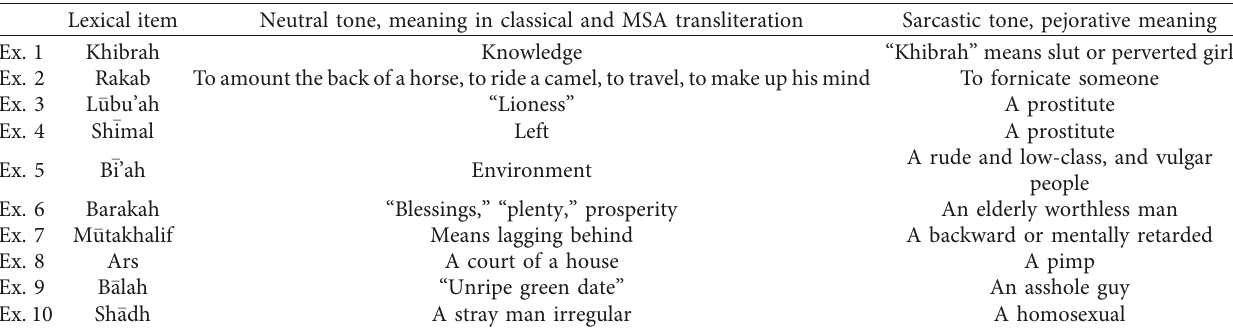
Table 1: Prosodic